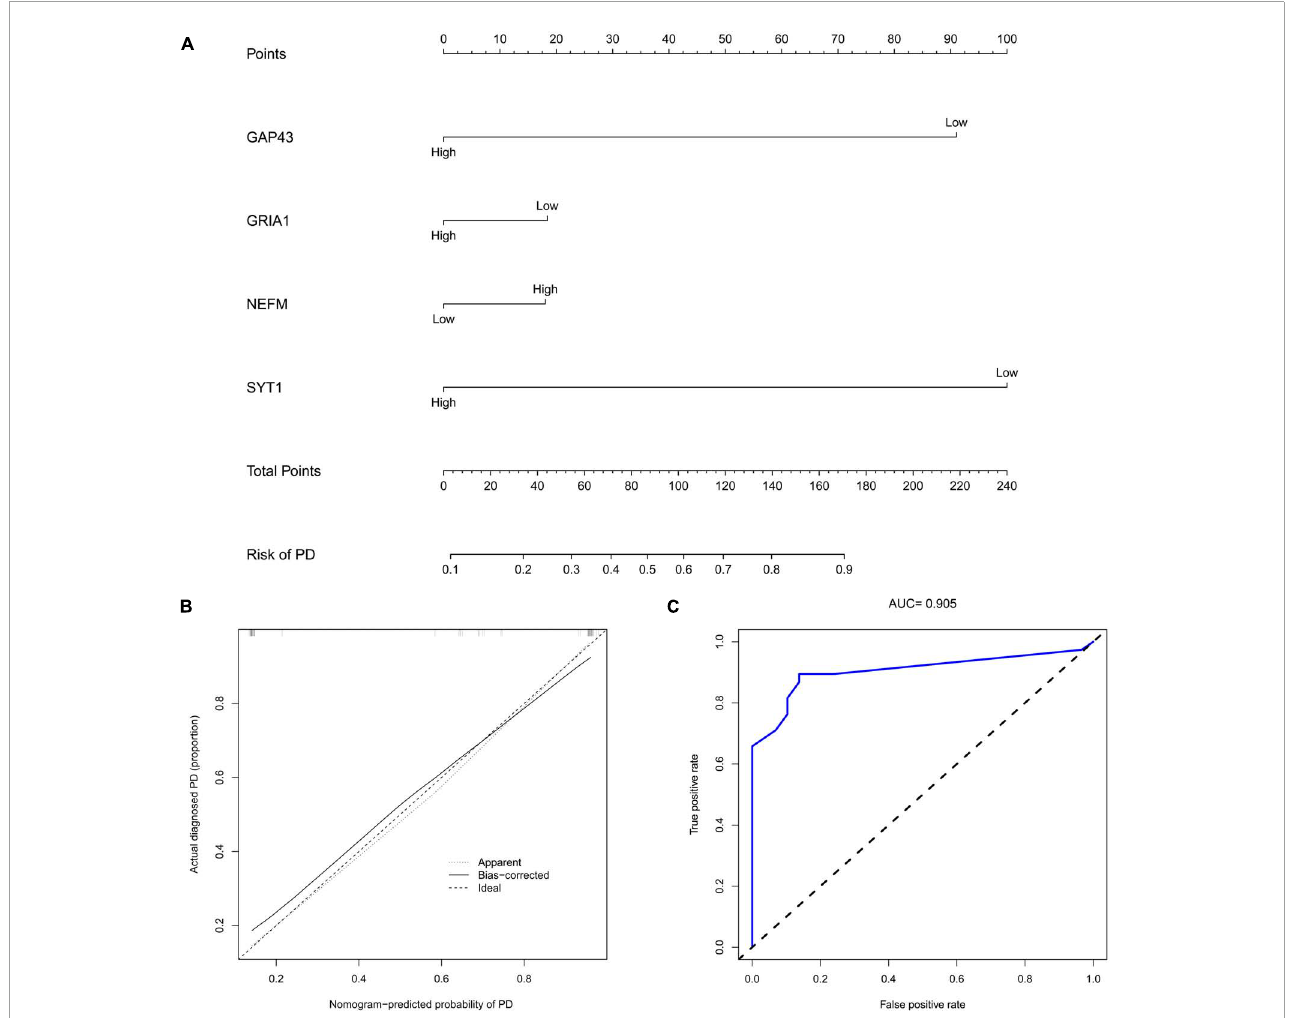
FIGURE10 Construction of the nomogram. (A) Construction of a nomogram for immune-related hub genes (GAP43, GRIA1, NEFM, and SYT1) for predicting the occurrence of PD. (B) Calibration curve estimates the prediction accuracy of the nomogram for PD patients. (C) The area under the curve (AUC) was 0.905. PD, Parkinson’s disease; AUC, area under the